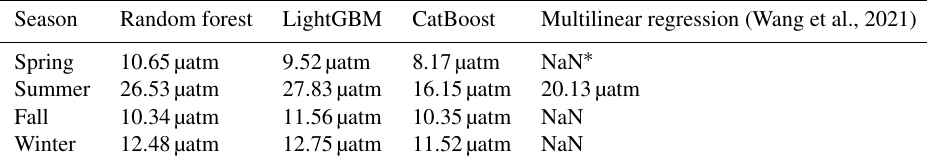
Table 3. RMSEs associated with different algorithms in the four seasons. Season Random